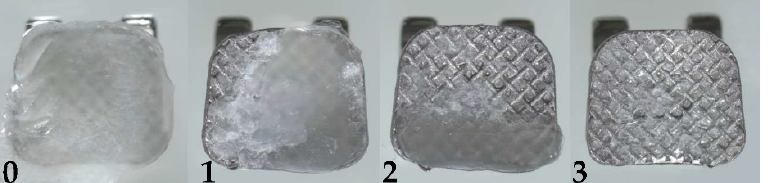
Figure 4. ARI, adhesive remnant index; 0, all adhesive remains on the bracket base; 1, ≥50% of the adhesive remains on the bracket base; 2, <50% of the adhesive remains on the bracket base; and 3, no adhesive remains on the bracket